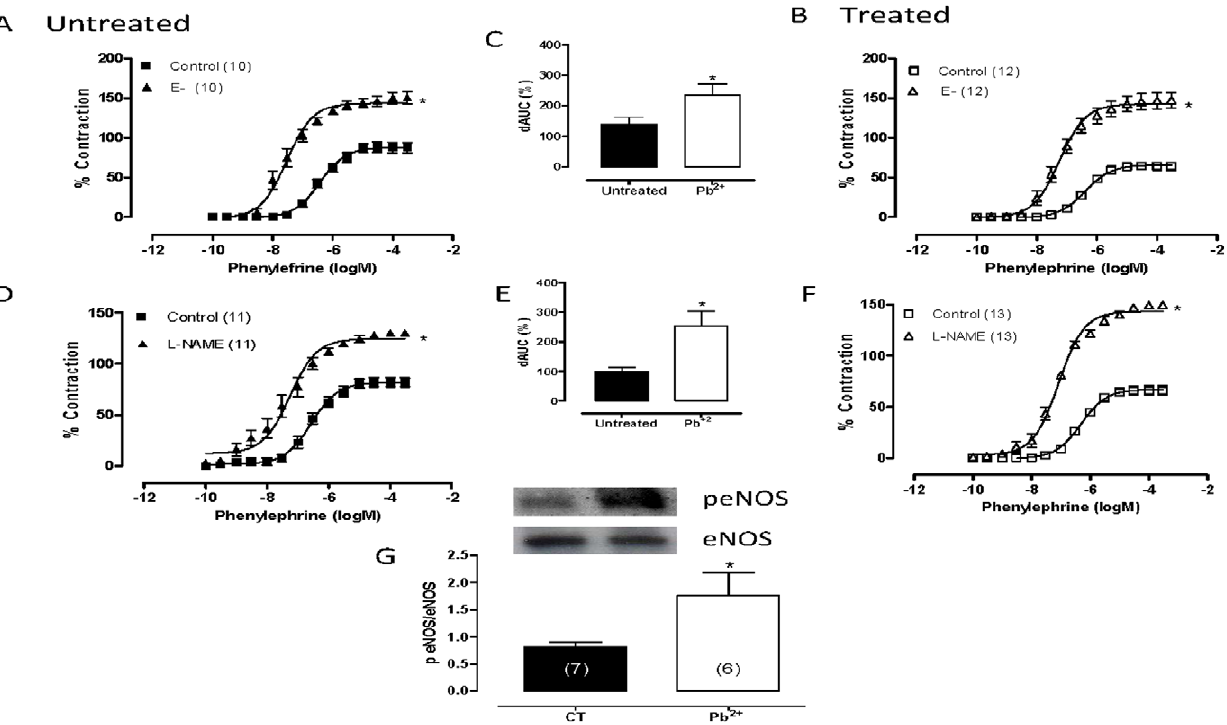
shows differences in area under the concentration-response curves (dAUC) in endothelium–denuded and intact segments (C) and in the presence and absence of L-NAME (F). Densitometry analyses of western blots for endothelial nitric oxide synthase (eNOS) and phosphorylated endothelial nitric oxide synthase (p-eNOS) protein expression in aortas from untreated (CT) and lead-treated rats (Pb + 2 ) (G). Representative blots are also shown. *P , 0.05 by Student’s t- test. Number of animals used is indicated in parentheses.